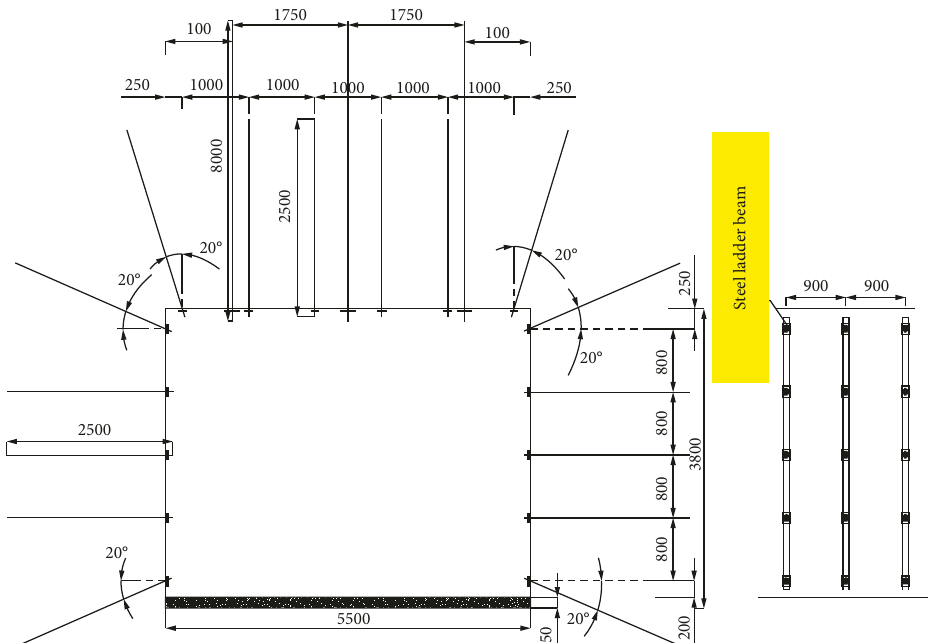
Figure 14: Schematic diagram of retracement laneway